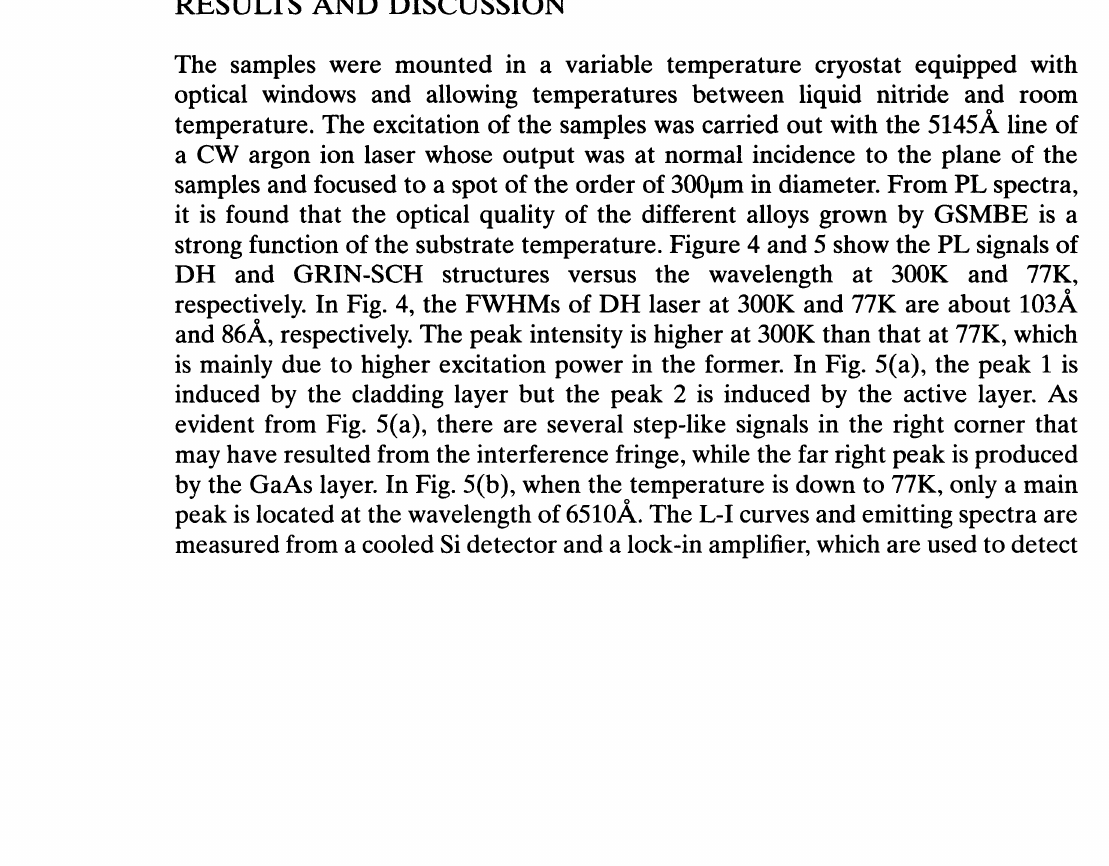
FIGURE 3 Schematic cross section of the AIInGaP/InGaP GRIN-SCH laser